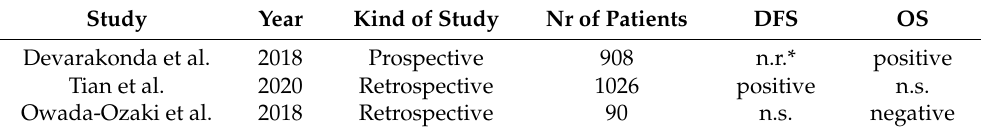
Table 5. Disease-free survival (DFS) and overall survival (OS) in early-stage NSCLC with high TMB. Study Year Kind of Study Nr of Patients DFS OS Devarakonda et al. Prospective 908 n.r.* positive Tian et al. Retrospective 1026 positive n.s. Owada-Ozaki et